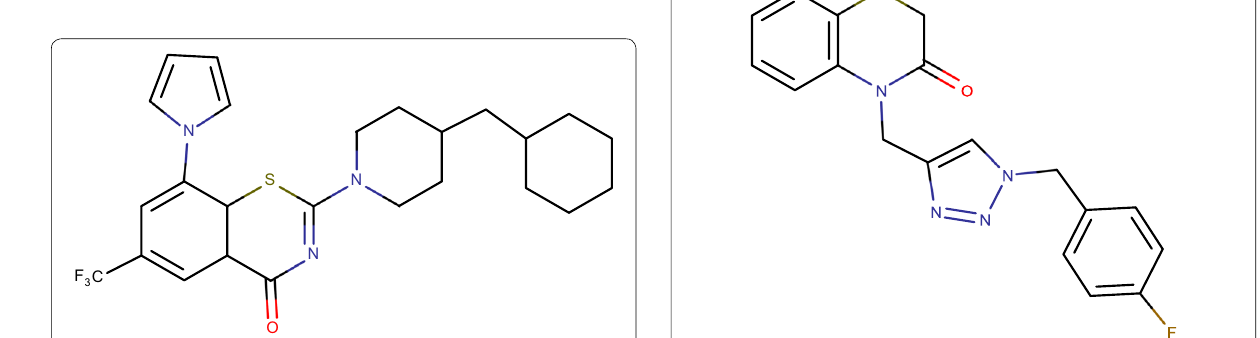
Fig. 11 PyrBTZ02 (8-pyrrole-BTZ) Fig. 12 1,2,4-Triazole containing 1,4-BTZ derivatives